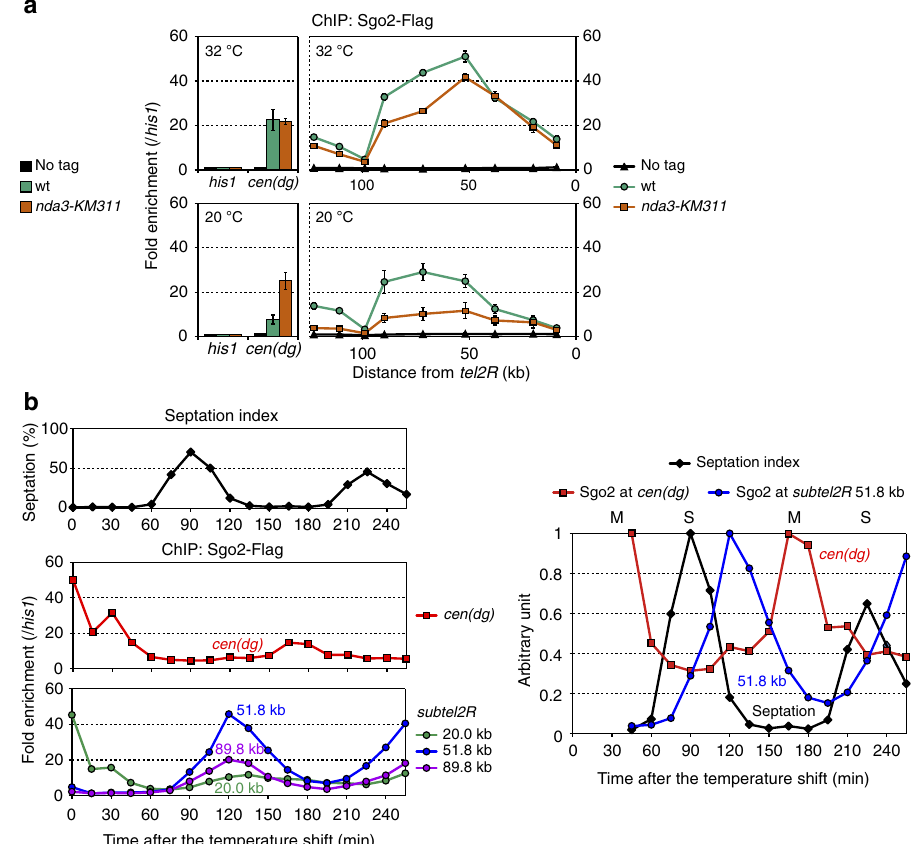
Figure 2 | Sgo2 associates with the subtelomeres preferentially in G 2 phase. ( a ) ChIP analyses of Sgo2-Flag localization at subtel2R in M phase. Cold-sensitive nda3-KM311 mutant and wt (control) cells were grown at 32 (cid:2) C (permissive temperature) or incubated at 20 (cid:2) C for 12h (restrictive temperature, M-phase-arrested) in YPD medium. Relative fold enrichment at subtel2R (right) and cen ( dg ) (left), normalized to the signal at the his1 þ locus, is shown. It is noteworthy that the DNA sequence of subtel2R within B 50kb of the end of the chromosome is highly similar to that of the other subtelomeres 7 ; therefore, the analysis cannot differentiate these common telomere-proximal subtelomeric regions. No tag indicates the negative control for ChIP. Error bars indicate the s.d. ( n ¼ 3). ( b ) ChIP analyses of Sgo2-Flag localization at subtel2R during the cell cycle. Temperature-sensitive cdc25-22 mutant cells were arrested at the G 2 /M boundary at 35.5 (cid:2) C (restrictive temperature) and then released from arrest by shifting to 25 (cid:2) C (permissive temperature). Cell cycle progression was monitored by the septation index (left, top). Relative fold enrichment at cen ( dg ) (left, middle) and at 20.0, 51.8 and 89.8kb from the telomere repeats in subtel2R (left, bottom), normalized to that at the his1 þ locus, is shown, together with a summary of the relative Sgo2 enrichment at cen ( dg ) and at the 51.8kb locus ( subtel2R ) (right). The time points 0, 15 and 30min are omitted from the graph because of a lack of periodicity as compared with later time points, possibly due to non-physiological cell cycle arrest caused by the cdc25-22